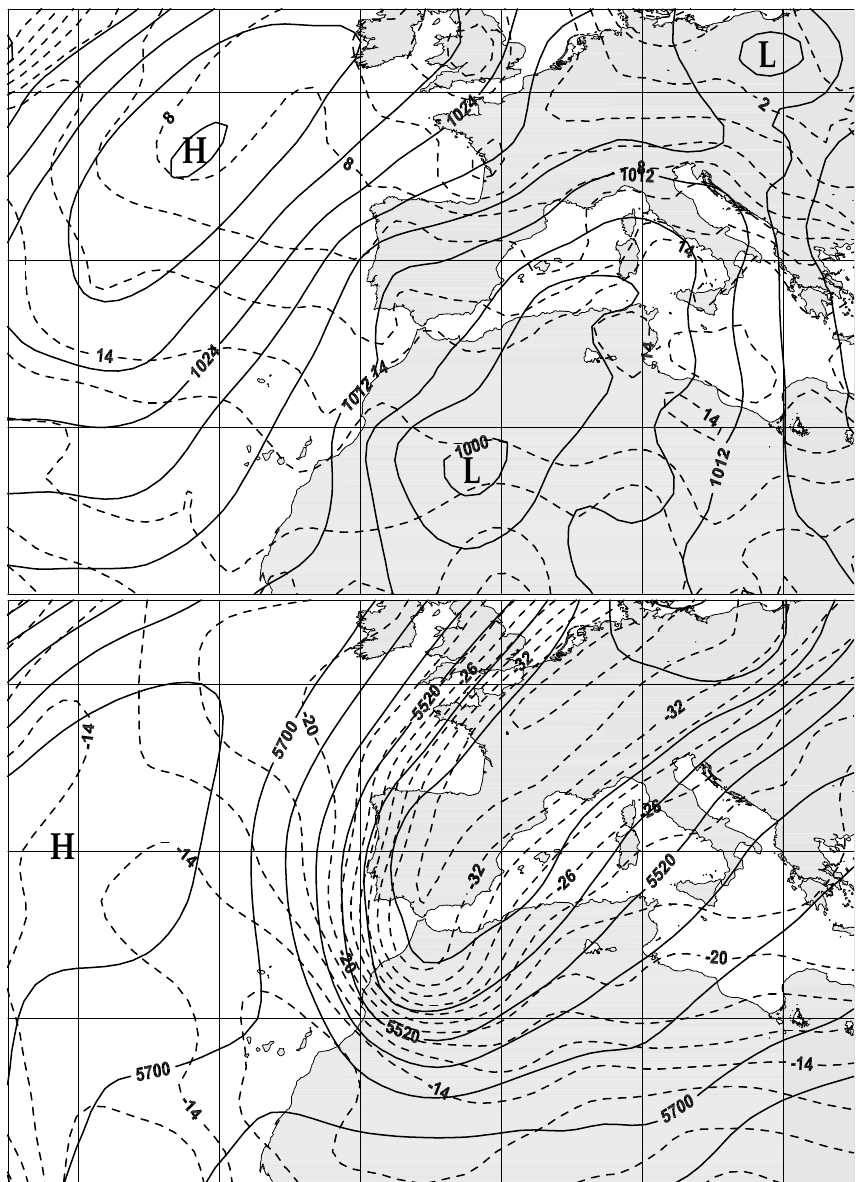
Fig. 4. As in Fig.3, but at 18:00UTC,